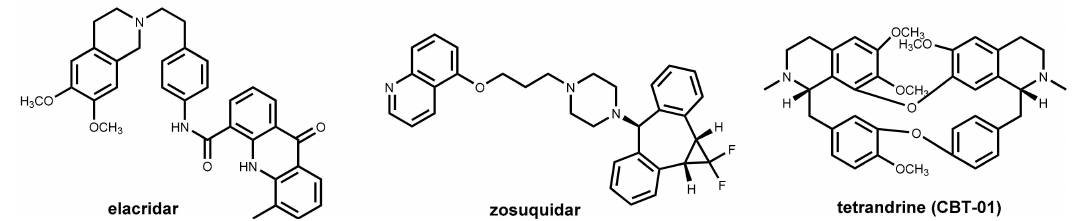
Figure 23. Structures of inhibitors of selected P-glycoprotein efflux pumps: elacridar, zosuquidar, and the alkaloid